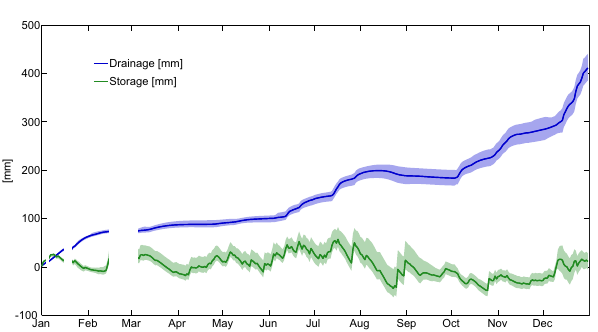
Figure 5. Cumulated average of lysimeter drainage and soil mois- ture storage on a daily basis. The colored areas indicate the range of minimum and maximum cumulated drainage and soil water storage for the individual